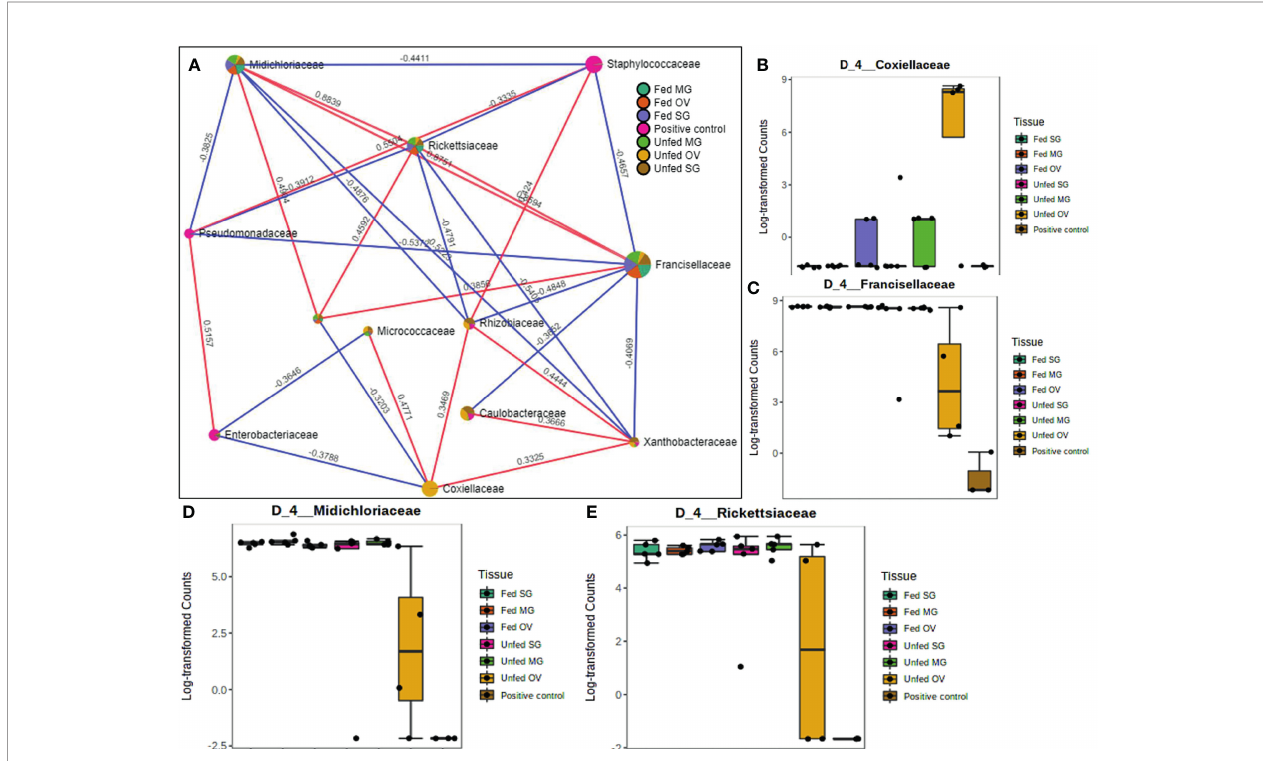
FIGURE 7 | Correlation network analysis in different tissues of laboratory-raised Amblyomma americanum ticks. Correlation network generated using the SparCC algorithm. Correlation network with nodes representing taxa at the family level and edges representing correlations between taxa pairs (A) and representative boxplots showing enriched abundance of Coxiellaceae (B) , Francisellaceae (C) , Midichloriaceae (D) , and Rickettsiaceae (E) across all